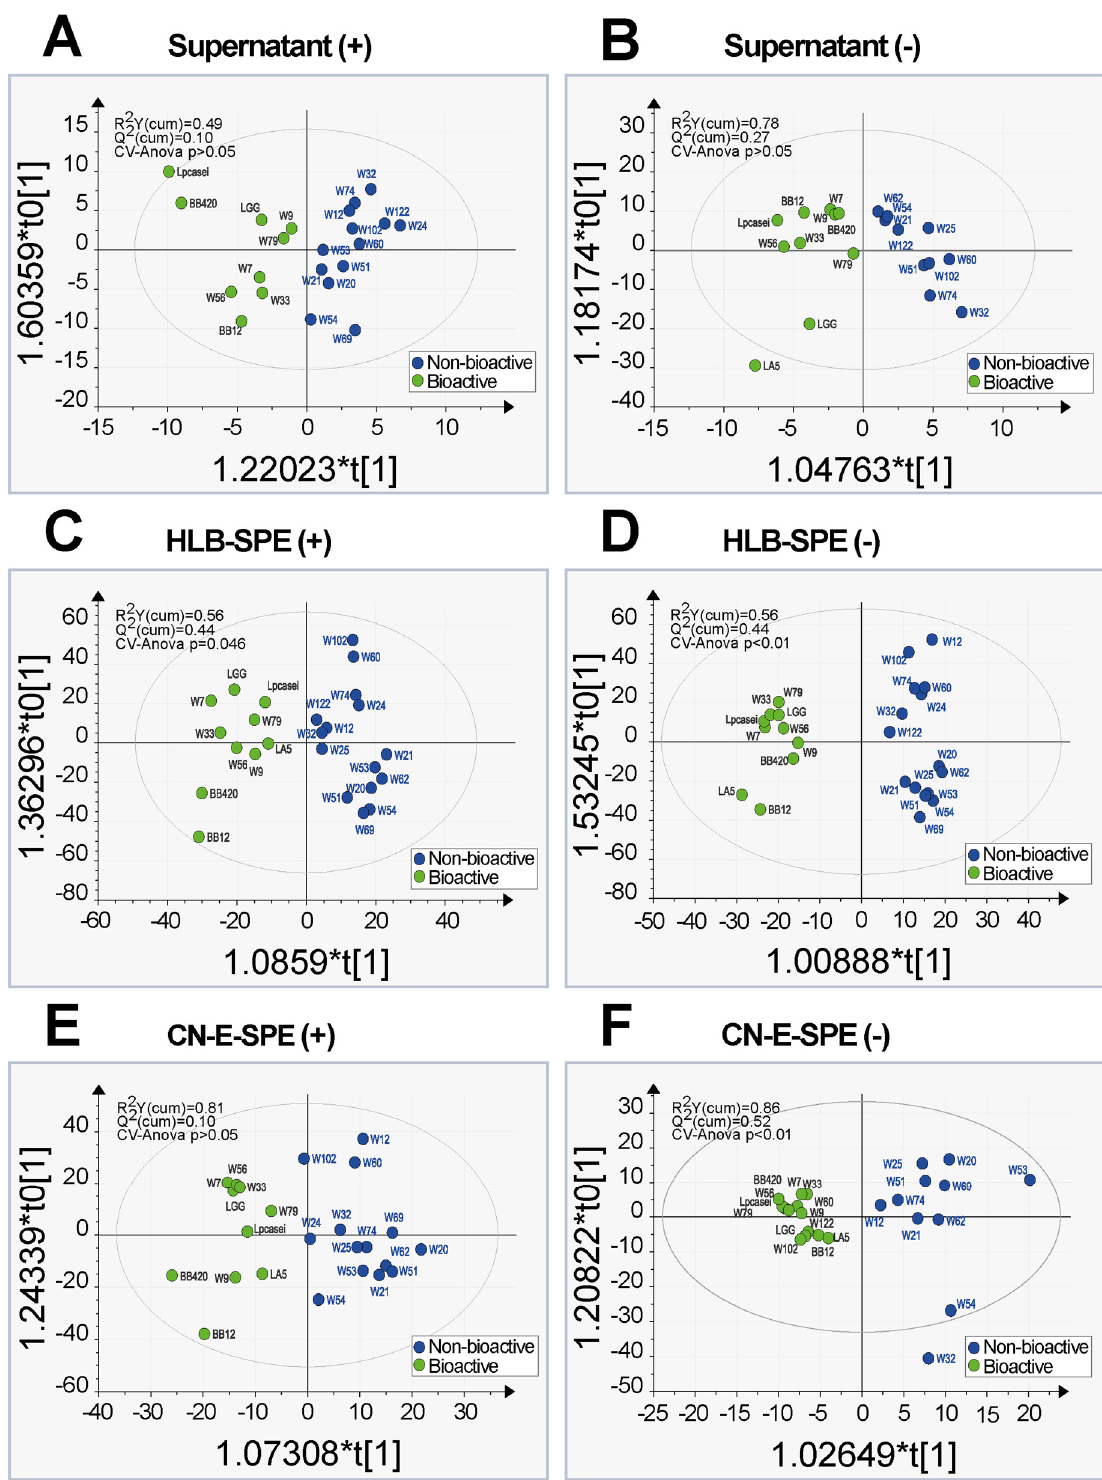
Figure 3. Supervised OPLS-DA scores plots. Models C, D and F are robust and have a high classi- fication power. Discriminant molecular features ( m / z ) observed in these three models were submitted to metabolic pathway analysis. The left side displays results obtained from FT-ICR-MS analyses in ESI positive mode ( A , C , E ) and the right side in ESI negative mode ( B , D , F ).